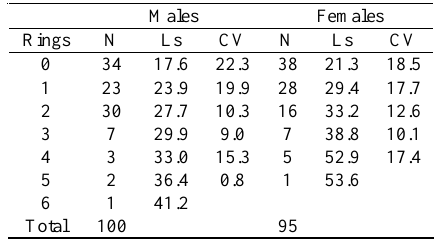
Table 2. Sample size (N), average standard length (Ls, cm) and coefficient of variation (CV) of the standard length per growth ring in Salminus brasiliensis scales from the area of influence of Corumbá Reservoir.